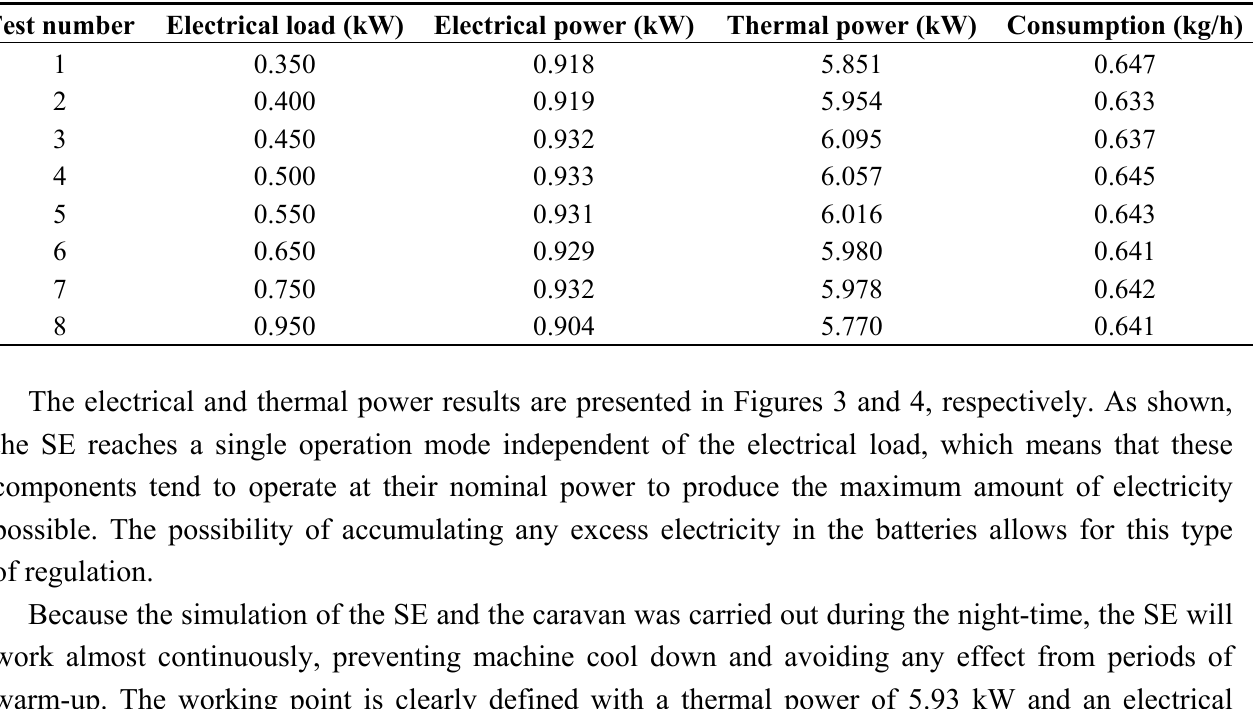
Table 1. Steady state results for different electric loads.